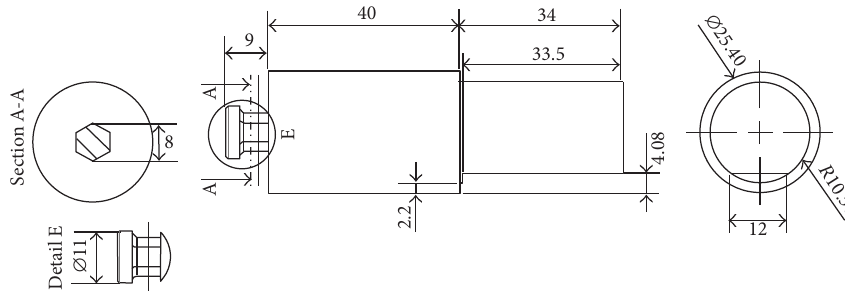
Figure 2: Dimensions (mm) for the “bolt-head” pin